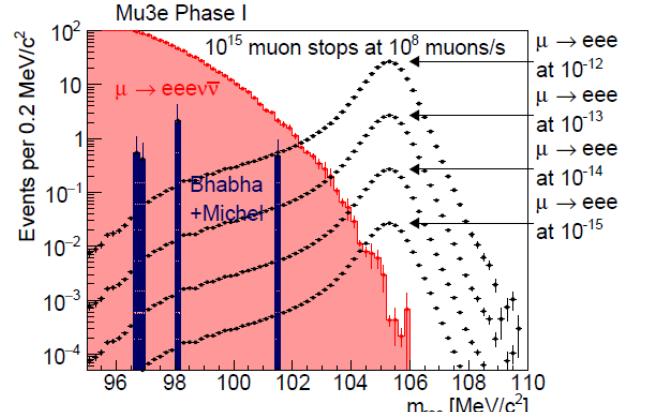
Figure 11: Reconstructed mass of three electrons from simulated internal conversion events, accidental combinations of Bhabha scattering events and Michel decays. In comparison, the µ → eee decay signal at various branching ratios is also